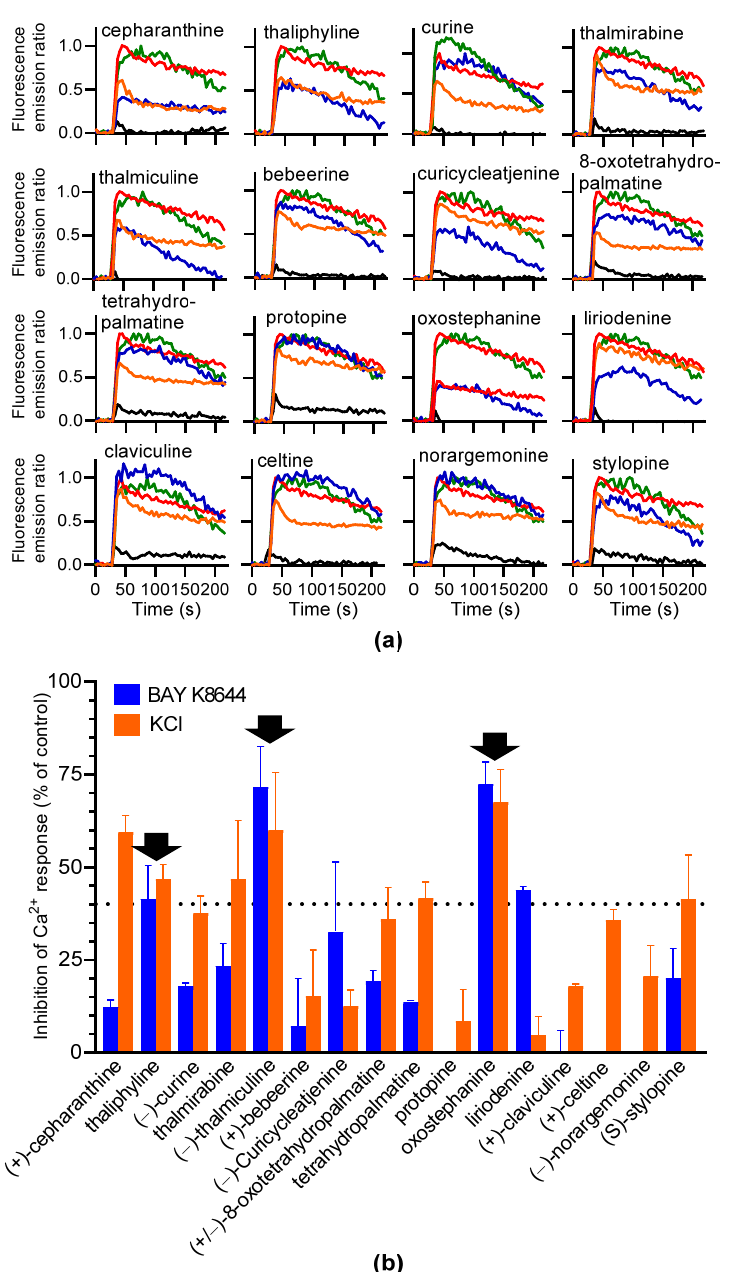
Figure 4. Screening of 16 IAs for inhibiting BAY K8644 or KCl-induced Ca 2+ response in GH3b6 cells. ( a ) The kinetic traces show the fluorescence emission ratio over time after injection of each IA (10 µ M), alone (black line), with 1 µM of BAY K8644 (blue line), or with 10 mM of KCl (orange line). BAY K8644 (green line) and KCl (red line) were injected alone as positive controls. Data are means ( n = 3). ( b ) The histogram shows the inhibitory effects in % of each IA on BAY K8644 and KCl-induced Ca 2+ responses. The black arrows point out the IAs, which inhibit both BAY K8644 and KCl -induced Ca 2+ responses at more than 40 % (dashed horizontal line). Data are means ± SEM ( n = 3–4).